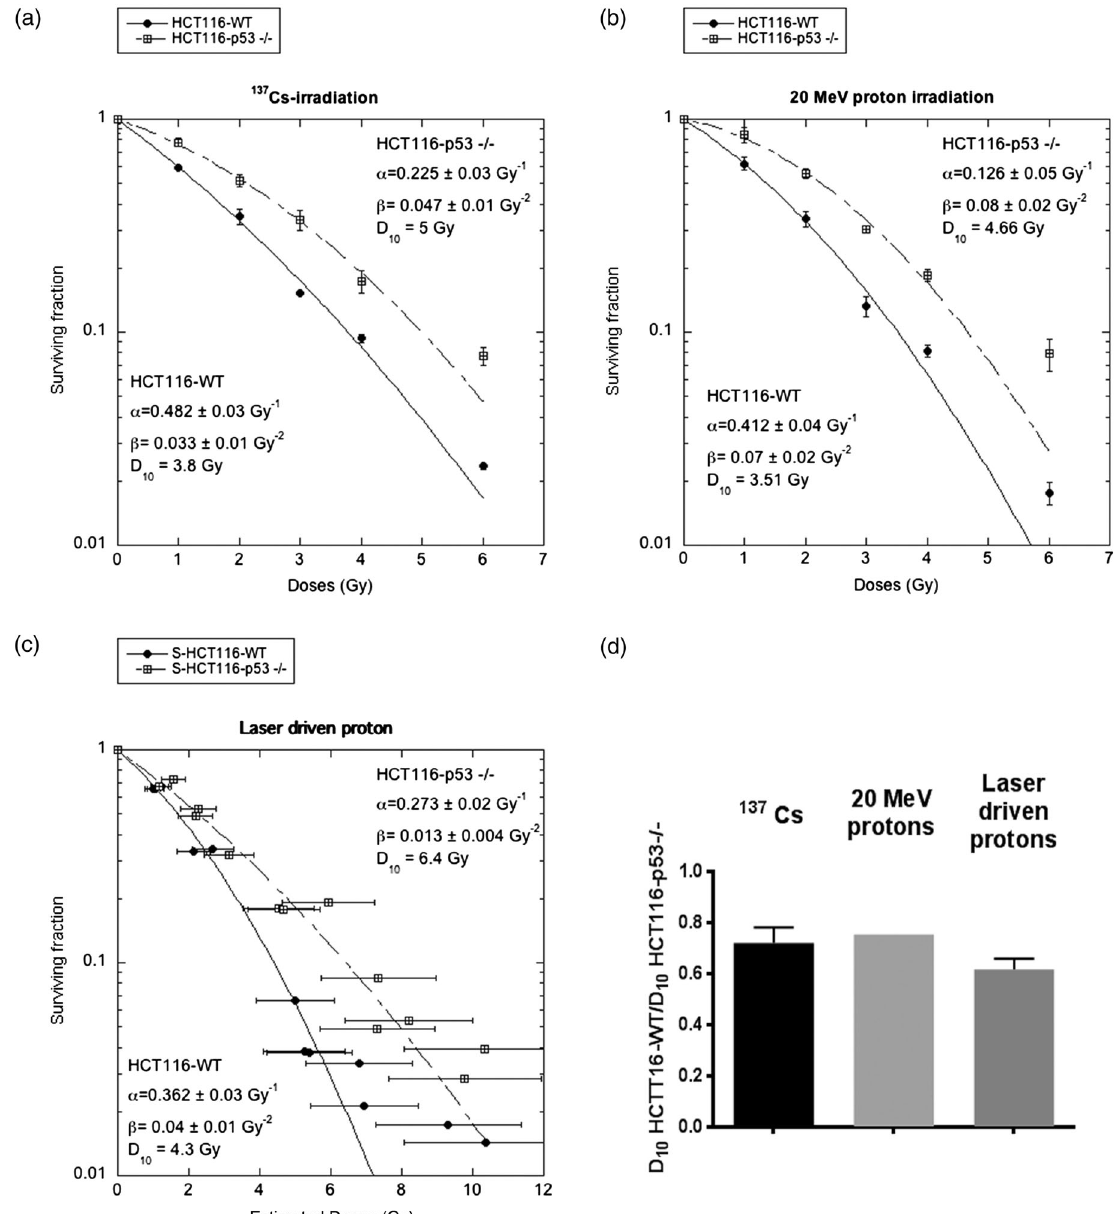
FIG. 10. Survival curves of HCT116-WT and p 53 − = − cells after 137 Cs (a, mean (cid:1) SD of three independent experiments), 20 MeV proton (b, mean (cid:1) SD of two independent experiments) or laser-driven irradiations (c, mean (cid:1) SD of three independent experiments). (d) Calculated D10 ratio between HCT116-WT and p 53 − = − cells for each irradiation